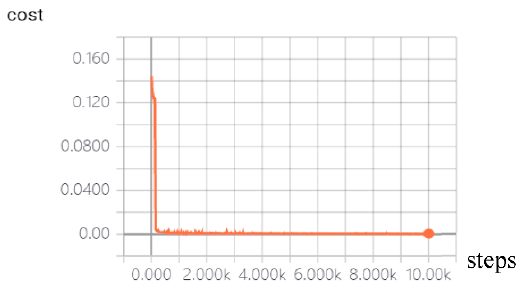
Figure 15. The loss function curves of RSPCN.